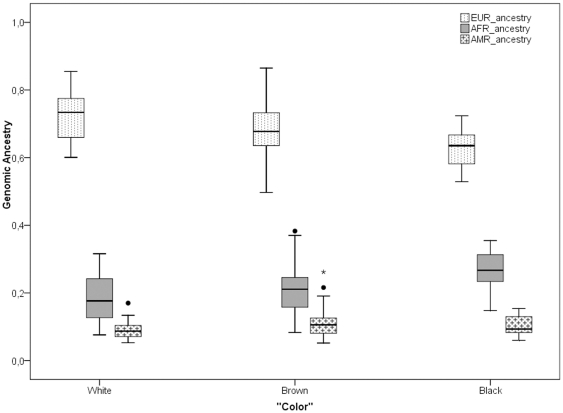
Genetic ancestry proportions×“Color”.